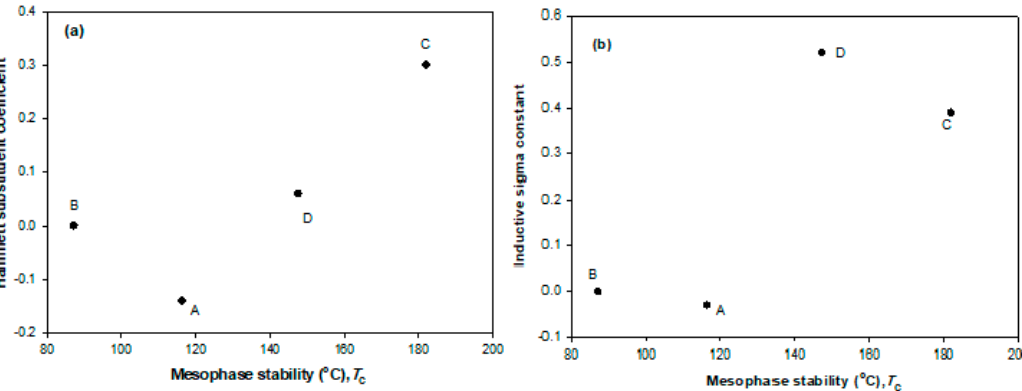
Figure 6. Dependence of the T c against ( a ) Hammett substituent coefficient ( σ ), ( b ) inductive sigma constant ( σ I) of compounds A – D .